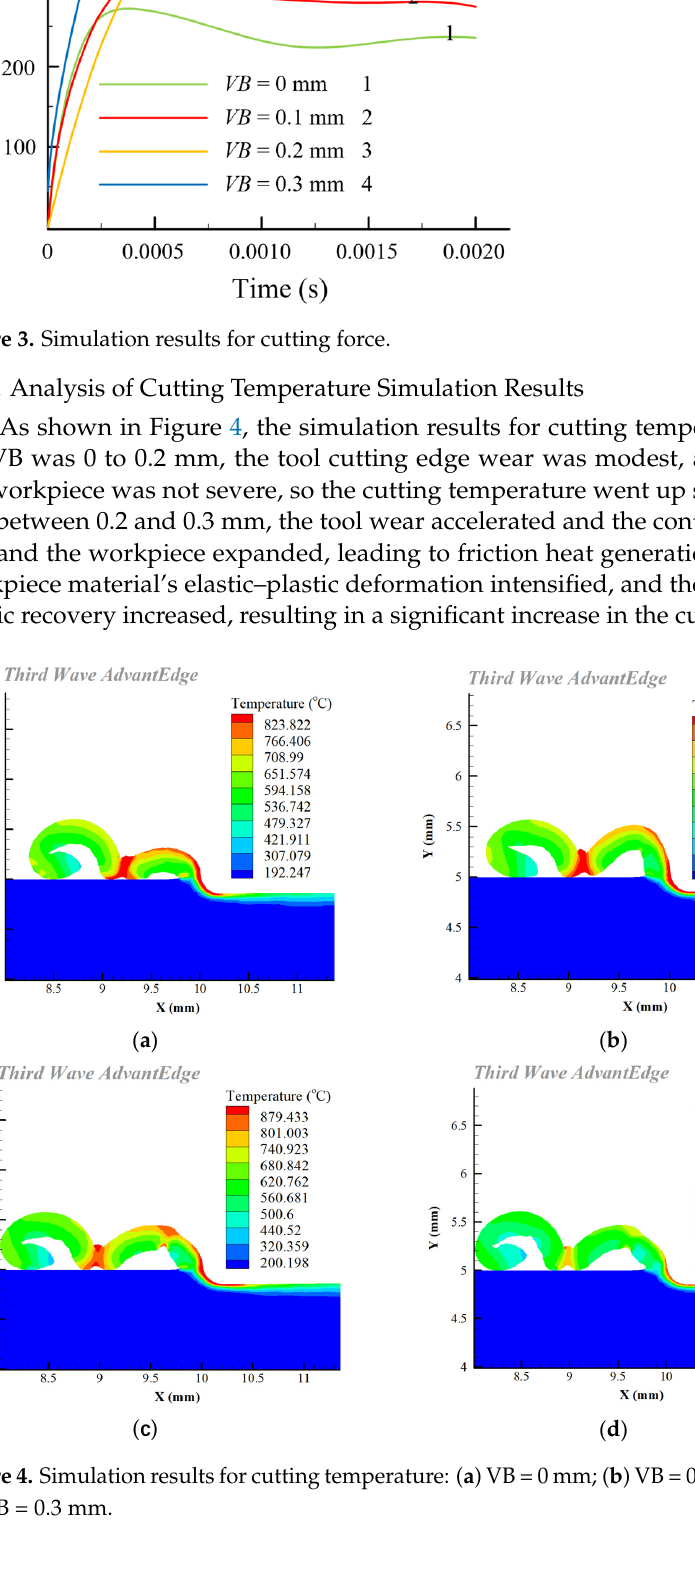
( d ) Figure 4. Simulation results for cu tt ing temperature : ( a ) VB = 0 mm; ( b ) VB = 0.1 mm; ( c ) VB = 0.2 mm; ( d ) VB = 0.3 mm.